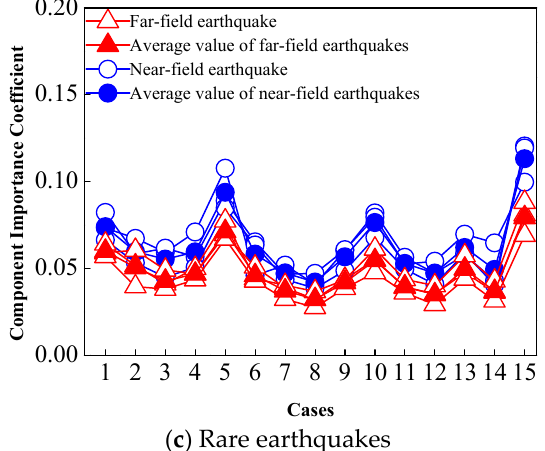
Figure 8. Component importance coefficient curves of model.